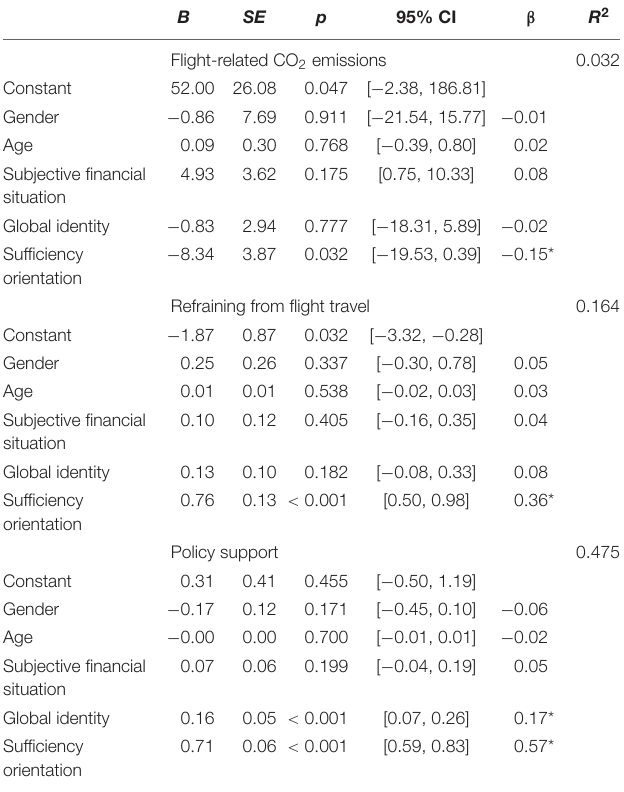
TABLE 3 | Results of regressing the flight-related measures and policy support on global identity and sufficiency orientation (mean